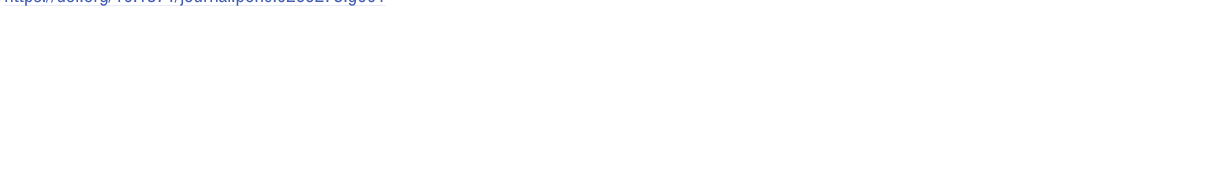
PLOS ONE | https://doi.org/10.1371/journal.pone.0269273 June 3, 2022 5 /